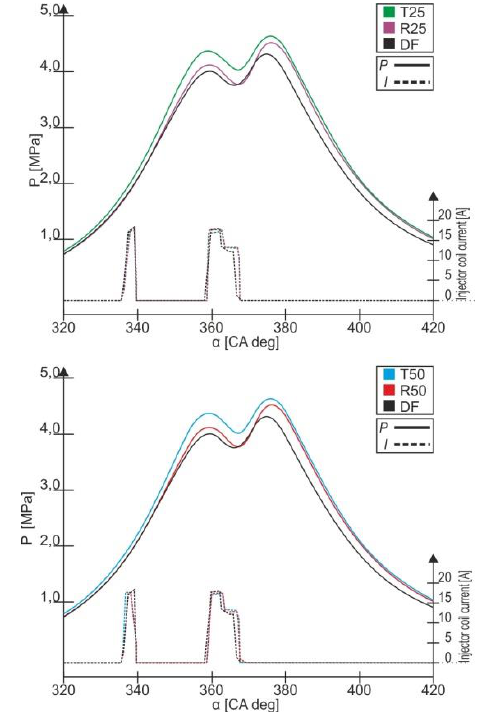
Fig. 3. In-cylinder pressure and injection current versus CA for 100 Nm load